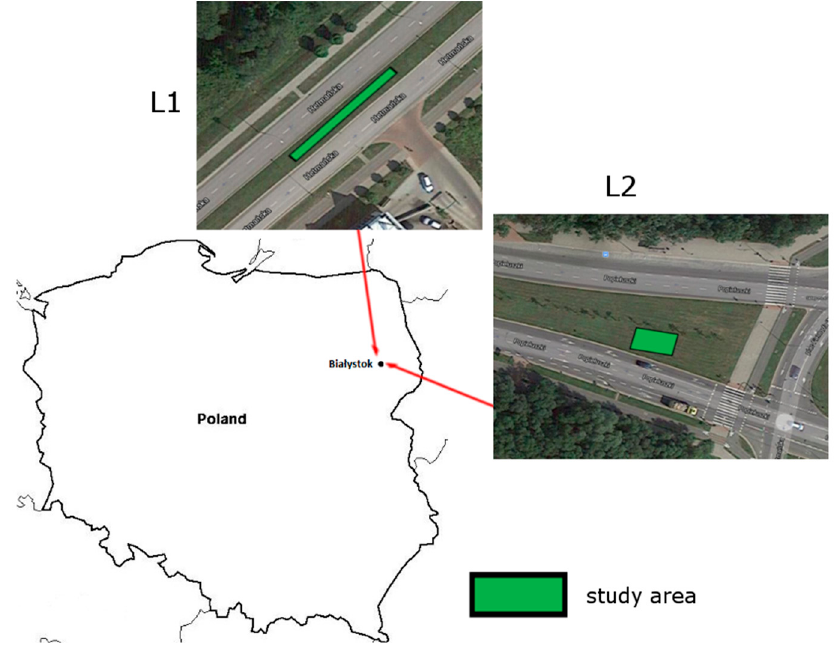
Figure 1. The position of the study area situated in Białystok city in the northeast part of Poland. L1 and L2 are the localizations of the study area along communication routes.